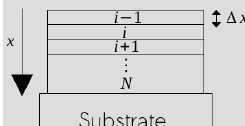
Figure 2. Division of the film in several layers of equal thickness during the discretization